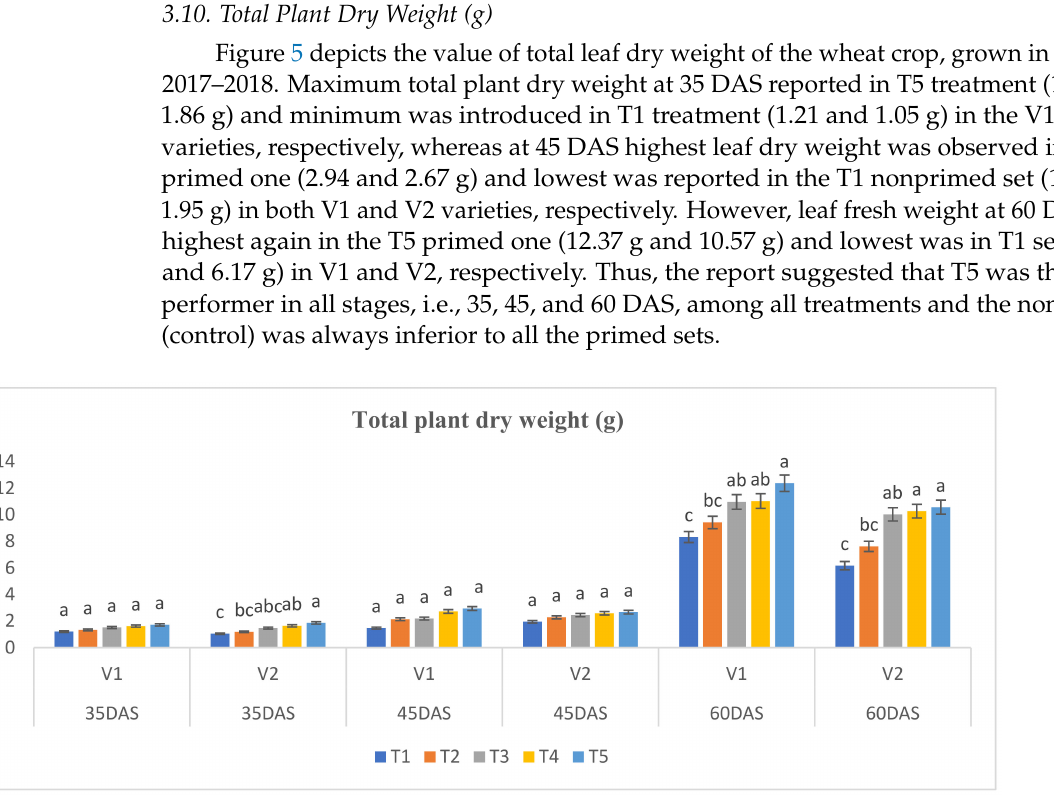
Figure 5. Effect of hydro, Mg(NO 3 ) 2 , ZnSO 4 , Mg(NO 3 ) 2 + ZnSO 4 primed and nonprimed (control) seed treatments on total plant dry biomass (g) of wheat varieties, grown in the year 2017–2018. The full description of abbreviations T1, T2, T3, T4, T5, V1 and V2 are represented in material and methods section. Lowercase alphabetical letters (a,b,c) represents the significant differences between the different seed priming treatments (Tukey test; p <